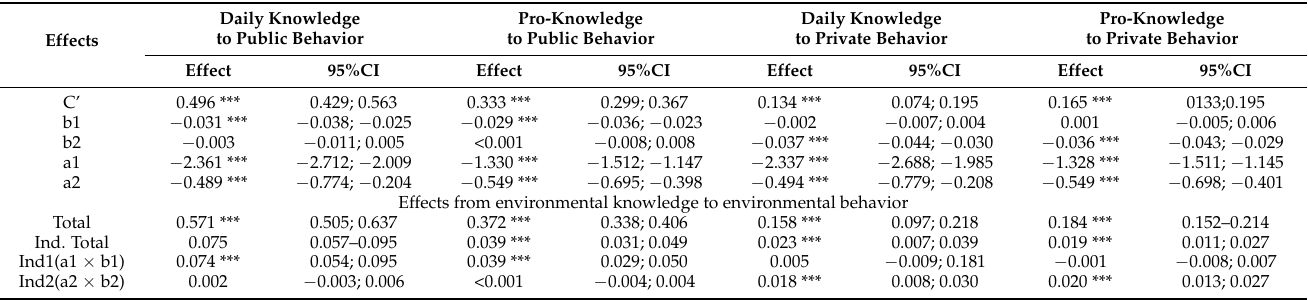
Table 2. Mediating coefficients for the explanatory model